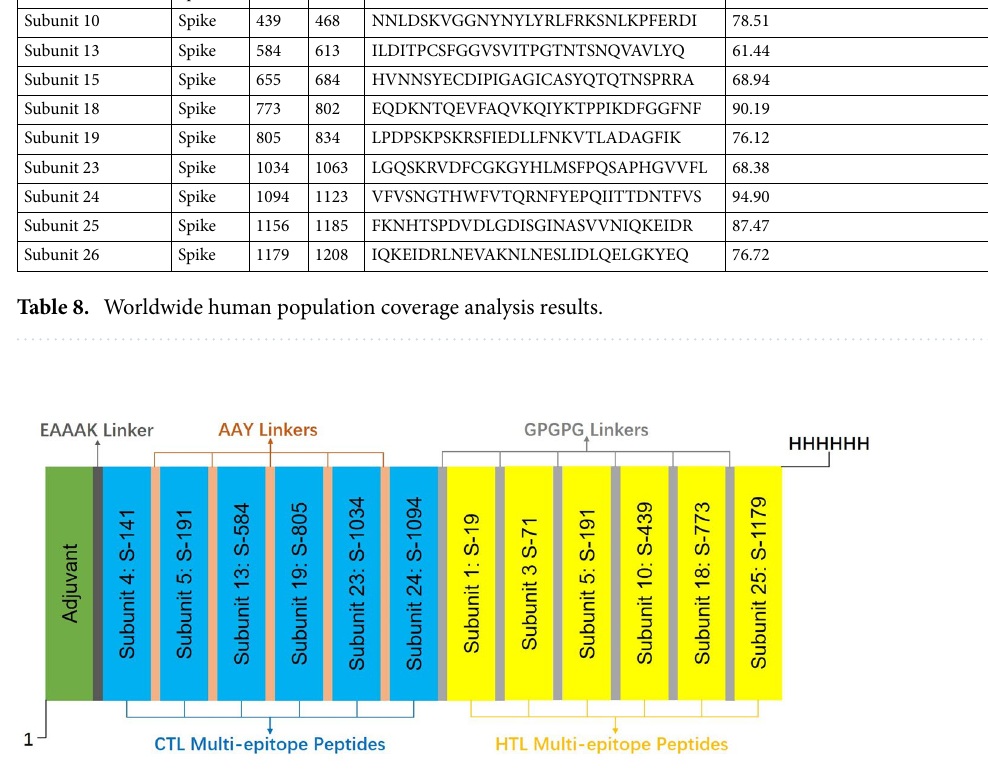
HLA-DRB1-1601 to evaluate their binding affinities and predict the potential HTL epitopes 45,47 . The total HLA score is calculated for each vaccine subunits. The results appears in Table 7.